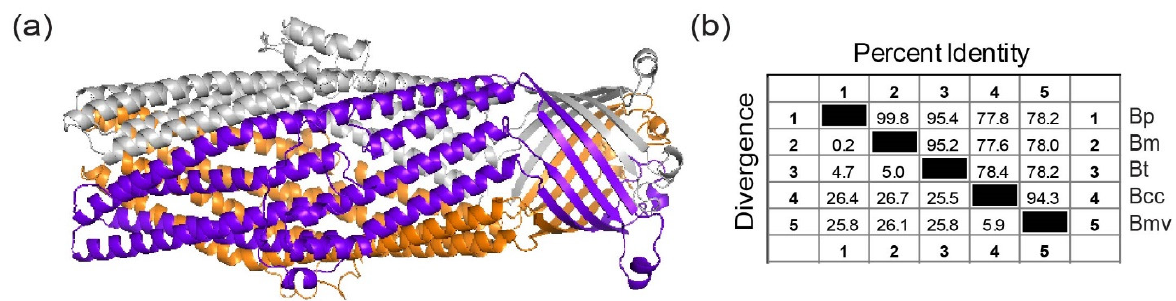
Figure 2. Identification and modeling of the Bucl8 variants in Burkholderia cepacia complex (BCC) organisms. ( a ) Bucl8-BCC variant lacks extracellular CL-Ct domain. Homology model of Bucl8-BCC protein from Burkholderia cenocepacia J2315 was generated with MODELLER using the structure of VceC (PDB code 1yc9, seqid 35%) as a template. ( b ) Sequence conservation of Bucl8-like proteins. Similarity matrix displays the Bucl8-sequence identity and divergence of B. pseudomallei (Bp) 1026b, B. mallei (Bm) ATCC 23344, B. thailandensis (Bt) E264, B. cenocepacia (Bcc) J2315, and B. multivorans (Bmv) ATCC BAA-247.